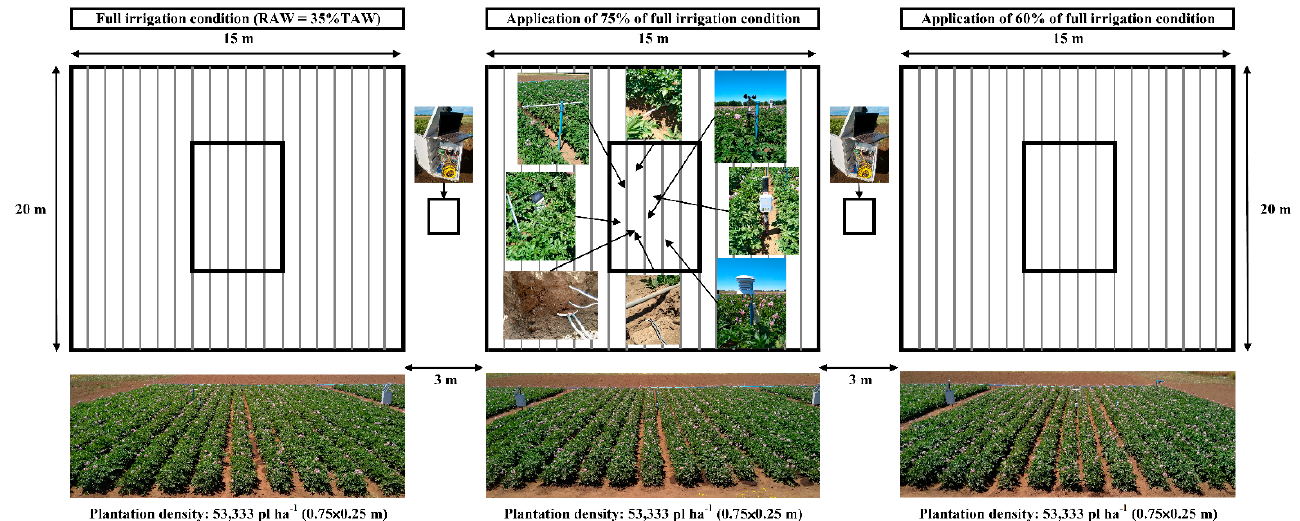
Figure 1. The general layout of the set instruments implemented in each evaluated irrigation levels conditions. At the central point of each irrigation level, the following instruments were installed: net radiometers, soil heat plates, and soil temperature probes, volumetric soil moisture sensors (for soil heat plates and soil water balance determinations), hygrometers, and anemometers. RAW and TAW are readily available soil water and total available soil water, and 35% is the p value according to Allen et al.